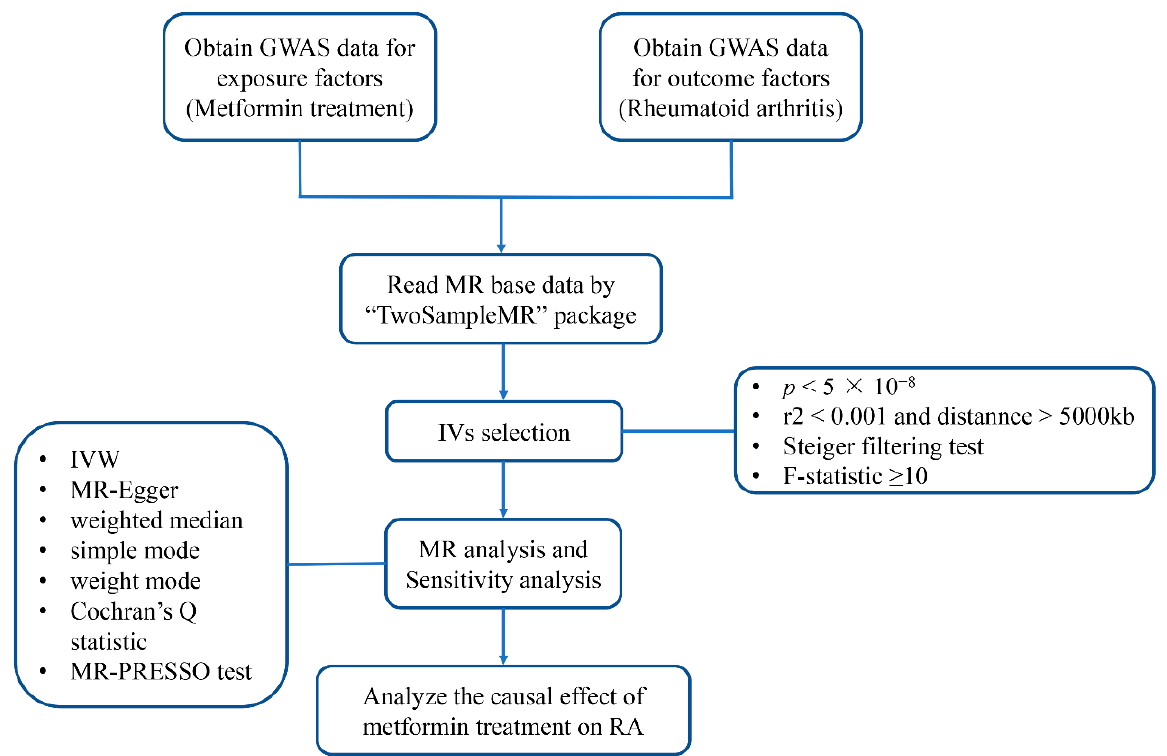
Figure 1. Workflow of the study. GWAS, genome-wide association study; IVs, instrumental variables; IVW, inverse variance-weighted; MR-PRESSO, Mendelian randomization pleiotropy residual sum and outlier; RA, rheumatoid arthritis.